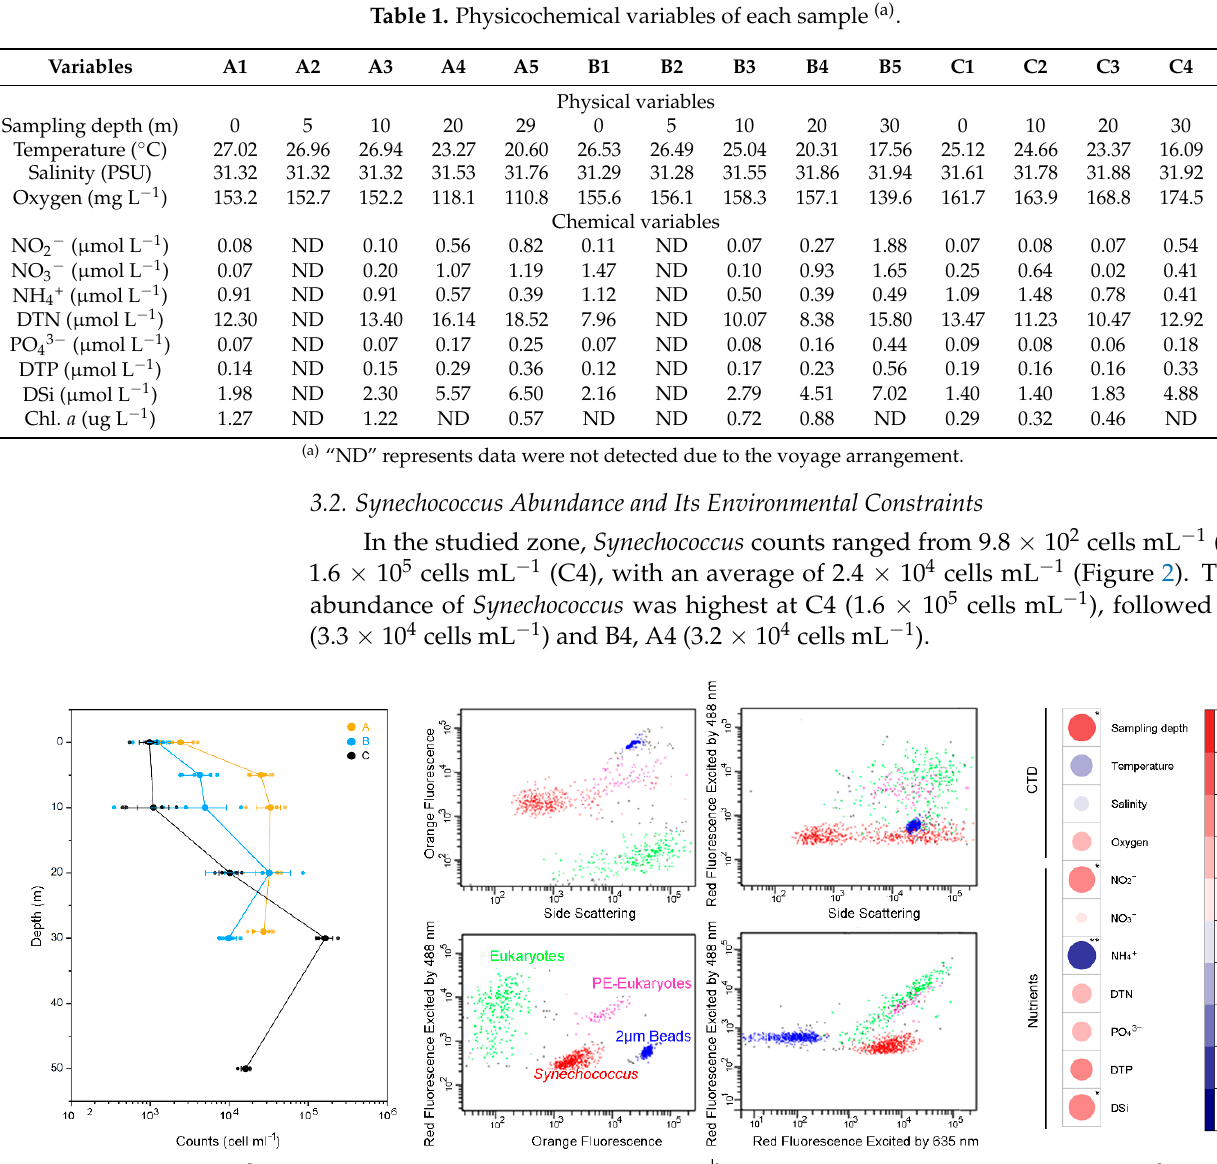
Table 1. Physicochemical variables of each sample (a) .